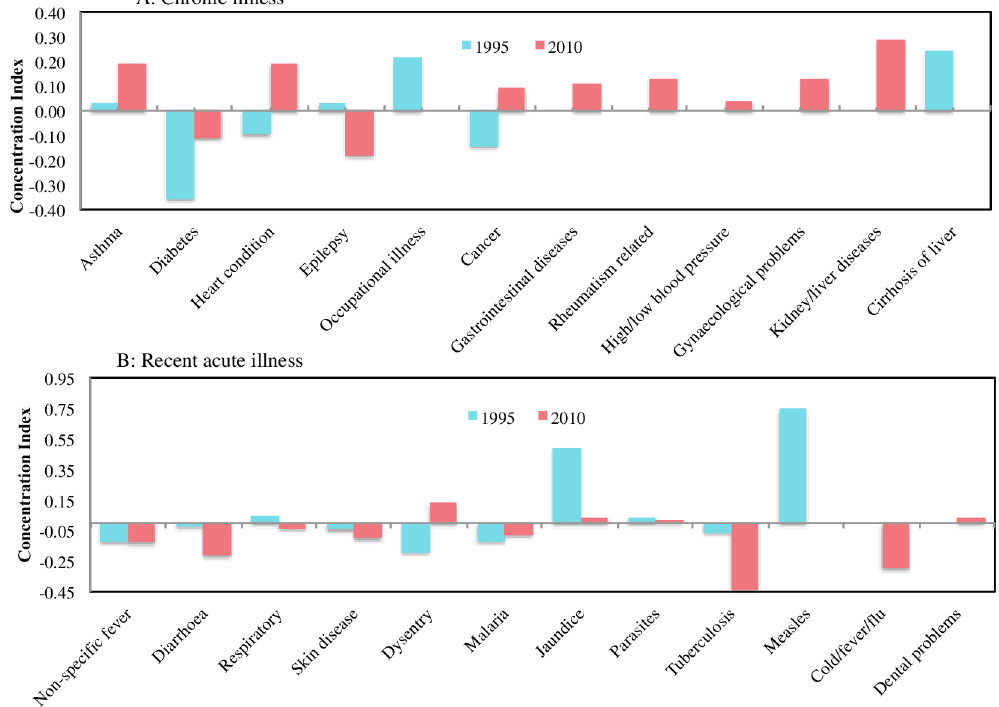
Fig 2. Concentration index for specific illnesses and symptoms in Nepal 1995–2010. (A) Chronic illness (B) Recent acute illness.